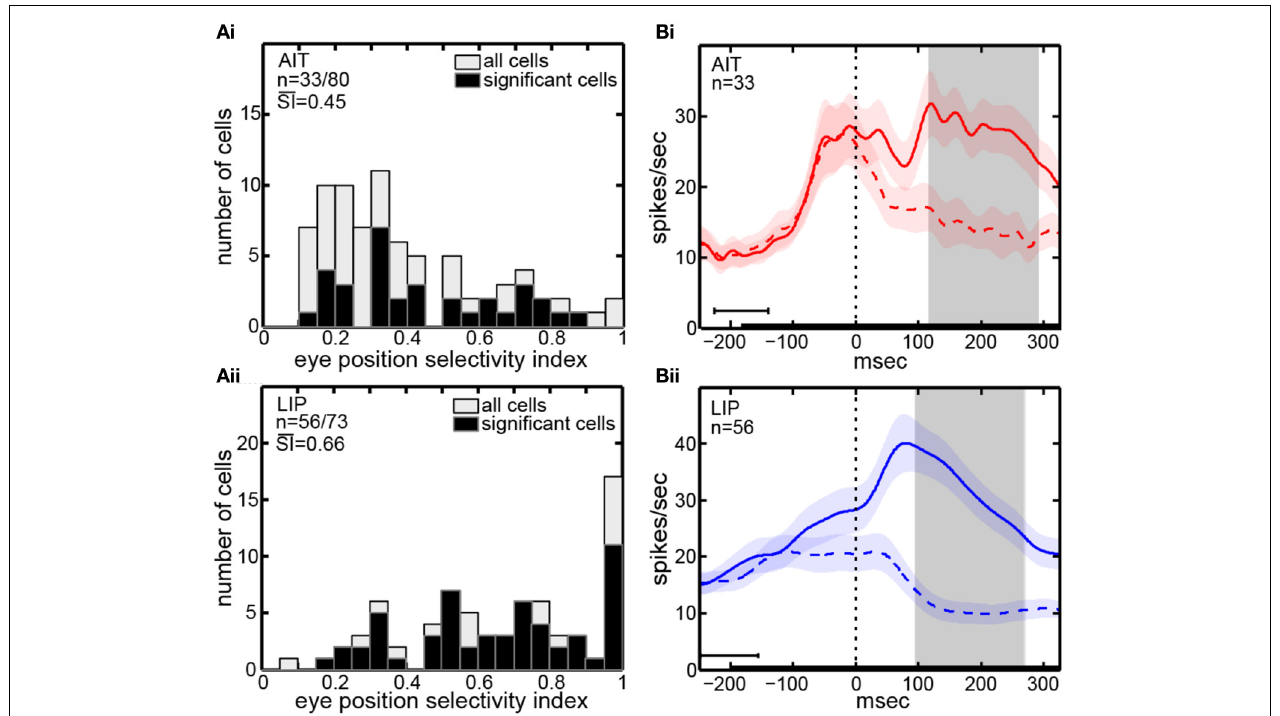
FIGURE 2 | Eye position selectivity. (A) Spatial selectivity index (SI) histograms for AIT (upper panel, Ai ) and LIP (lower panel, Aii ). The SI was calculated for each recorded cell using [Equation (1)]. Included are SI -values for all recorded cells (open bars; second n -value) as well as for only those cells showing significant spatial selectivity (black bars; first n -value). Mean SI -value for spatially significant cells is also shown in each panel indicating the average magnitude of the effects. (B) Average time course of responses (PSTH), aligned to start of saccade to target for AIT (upper panel, Bi , red lines) and LIP (lower panel, Bii , blue lines). Time course calculated over all cells showing significant selectivity for